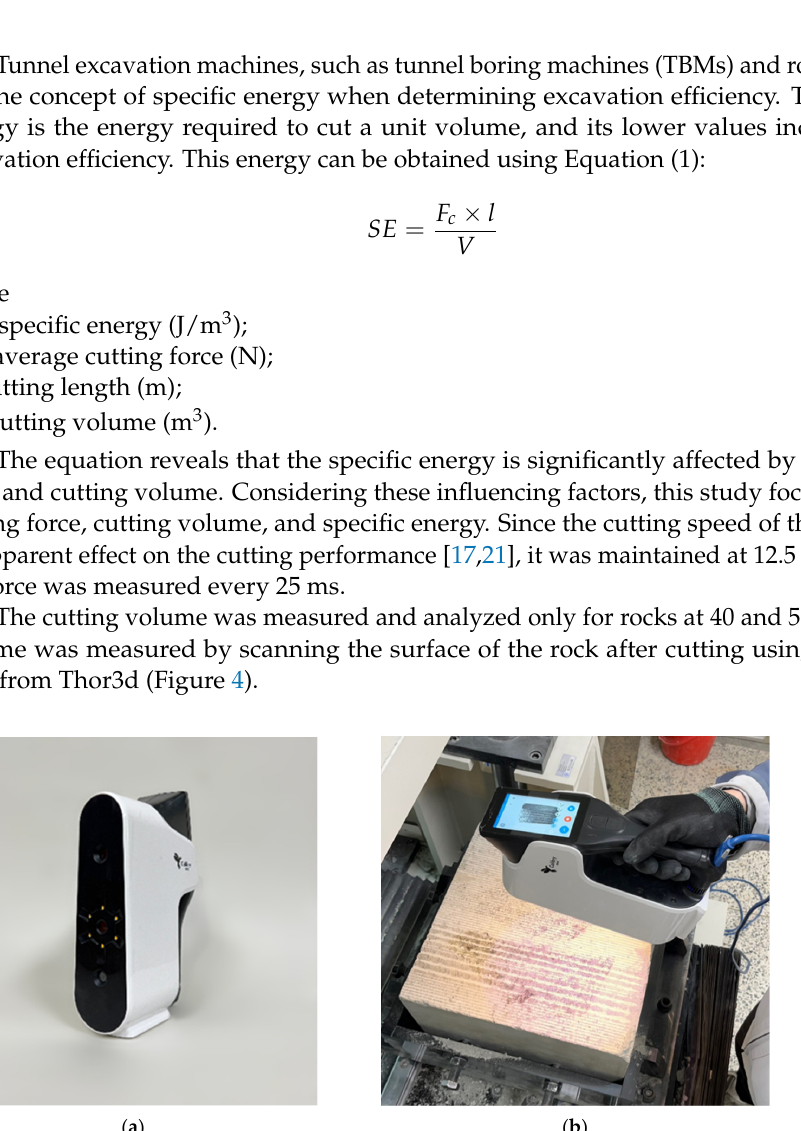
Figure 4. 3D scanning for volume measurement: ( a ) Calibry Mini and ( b ) example of 3D scanning.